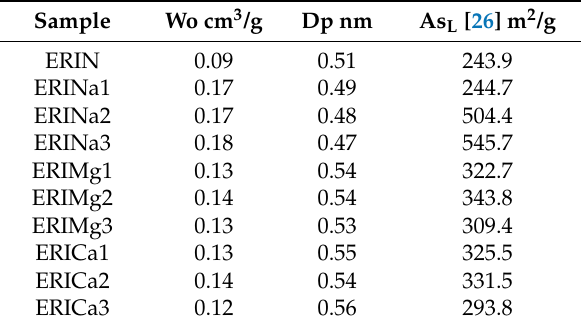
Table 3. Micropore volume (cm 3 /g), pore diameter (nm) (Dubinin-Astakhov theory—DA) and surface area (m 2 /g) (Langmuir method) of erionite zeolites. Sample Wo cm 3 /g Dp nm As L [26] m 2 /g ERIN 0.09